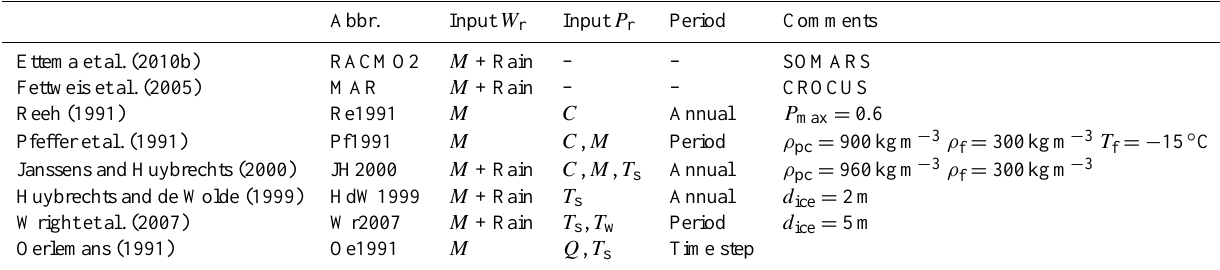
Table 1. The tested parameterizations. W r refers to whether the available water mass in Eq. (2) equals melt ( M ) or melt plus rain. Input P r lists the input fields to P r , period refers to the period over which the input fields to P r are averaged. The constants presented in the last column are chosen to correspond to the settings in the original publications. Note that RACMO2 fields are used as input and reference unless stated